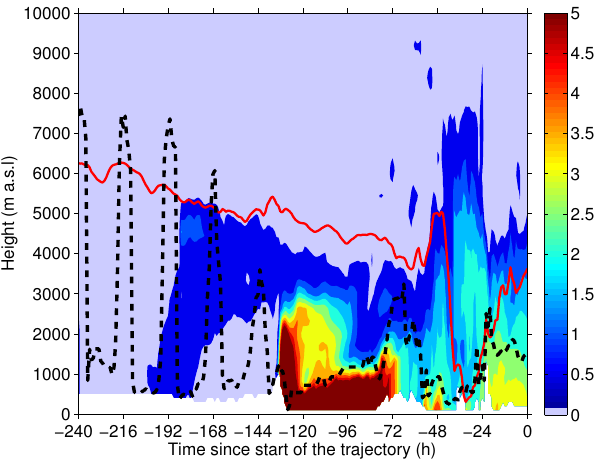
Figure 14. Vertical profile of the tagged specific humidity (in gkg − 1 ) of the sum of both Atlantic tracers along trajectory B in Fig. 11. The height of the air parcel is shown by the red solid line; the scaled boundary layer height is indicated by the black dashed